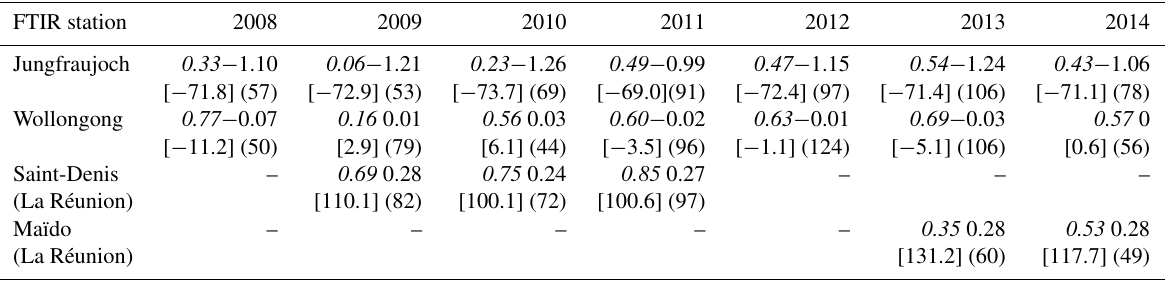
Table 3. Correlation coefficient (in italics), mean bias in 10 16 moleccm − 2 , and normalized mean bias (square brackets) in percent between the daily FTIR measurements and the IASI co-located data. The IASI data were chosen at ± 0.5 ◦ around the site location. The number of coincidence days is given in